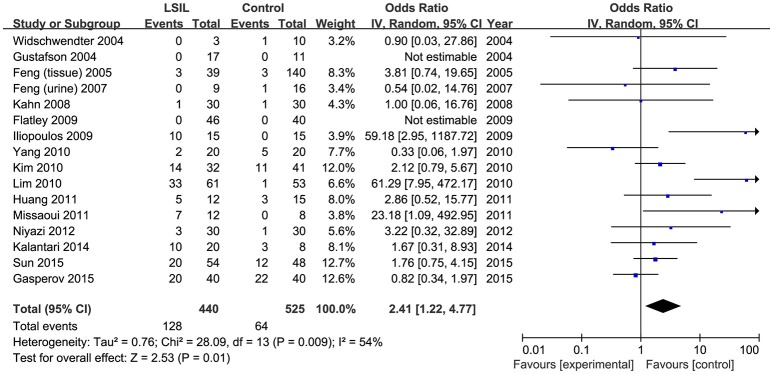
Funnel plots for the associations of DAPK1 promoter hypermethylation with the risk of LSIL. The squares represent the ORs for individual studies. The size of the square reflects the weight of included studies. Bars represent the 95% confidence intervals (CIs). The center of the diamond represents the summary effect size. LSIL, low-grade intra-epithelial lesion.